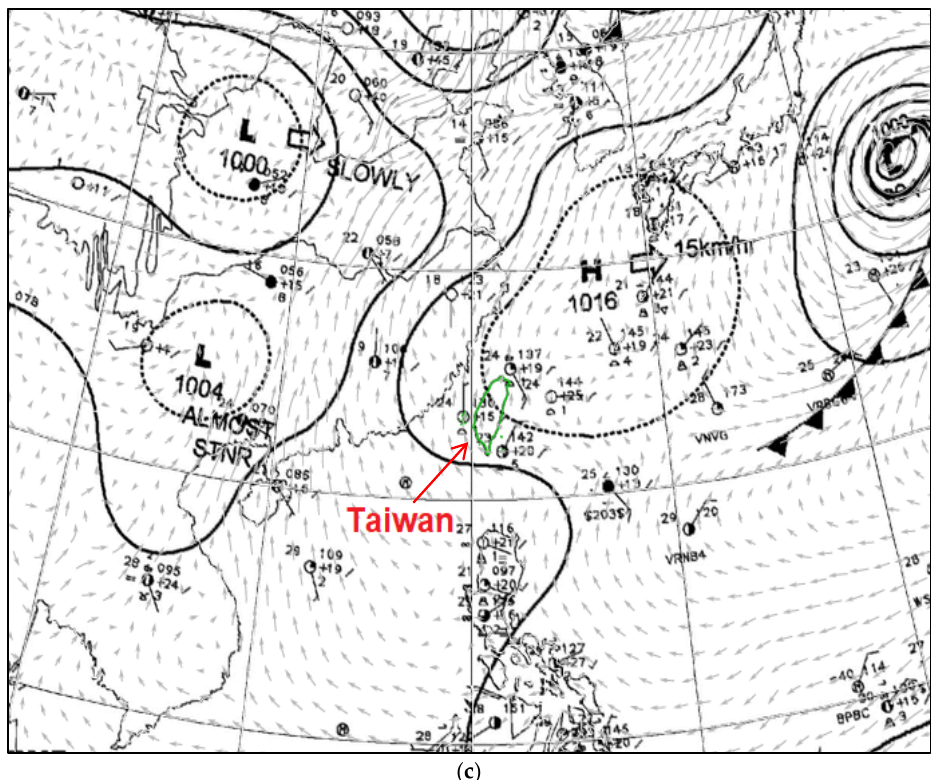
Figure 3. Examples of the three main synoptic weather patterns influencing Taiwan weather condi- tions in the winter: ( a ) 6 February 2016 14:00 LST; type I: a continental high-pressure system was over the Asian continent, and the north-easterly monsoon winds prominently influenced the weather conditions in the Taipei metropolis; ( b ) 23 January 2017 14:00 LST; type II: a continental high-pressure system had left the Asian continent, but its centre was not further east than 125 ◦ E; ( c ) 18 April 2019 8:00 LST; type III: a continental high-pressure system had moved eastward, moving its centre east of 125 ◦ E, and the easterly or south-easterly winds affected the weather conditions in the Taipei metropolis (courtesy of the Department of Atmospheric Sciences at the Chinese Culture